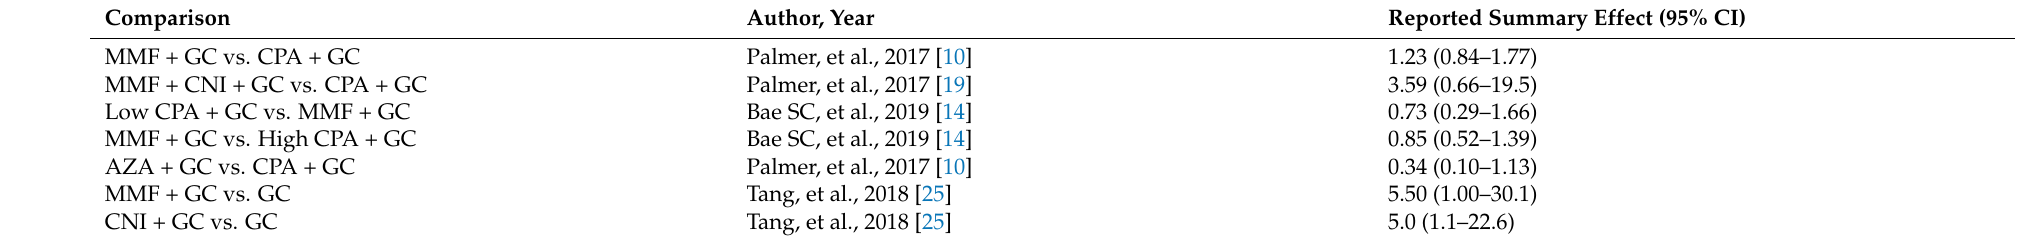
Table 13. Infection during treatment of lupus nephritis (Network meta-analysis).